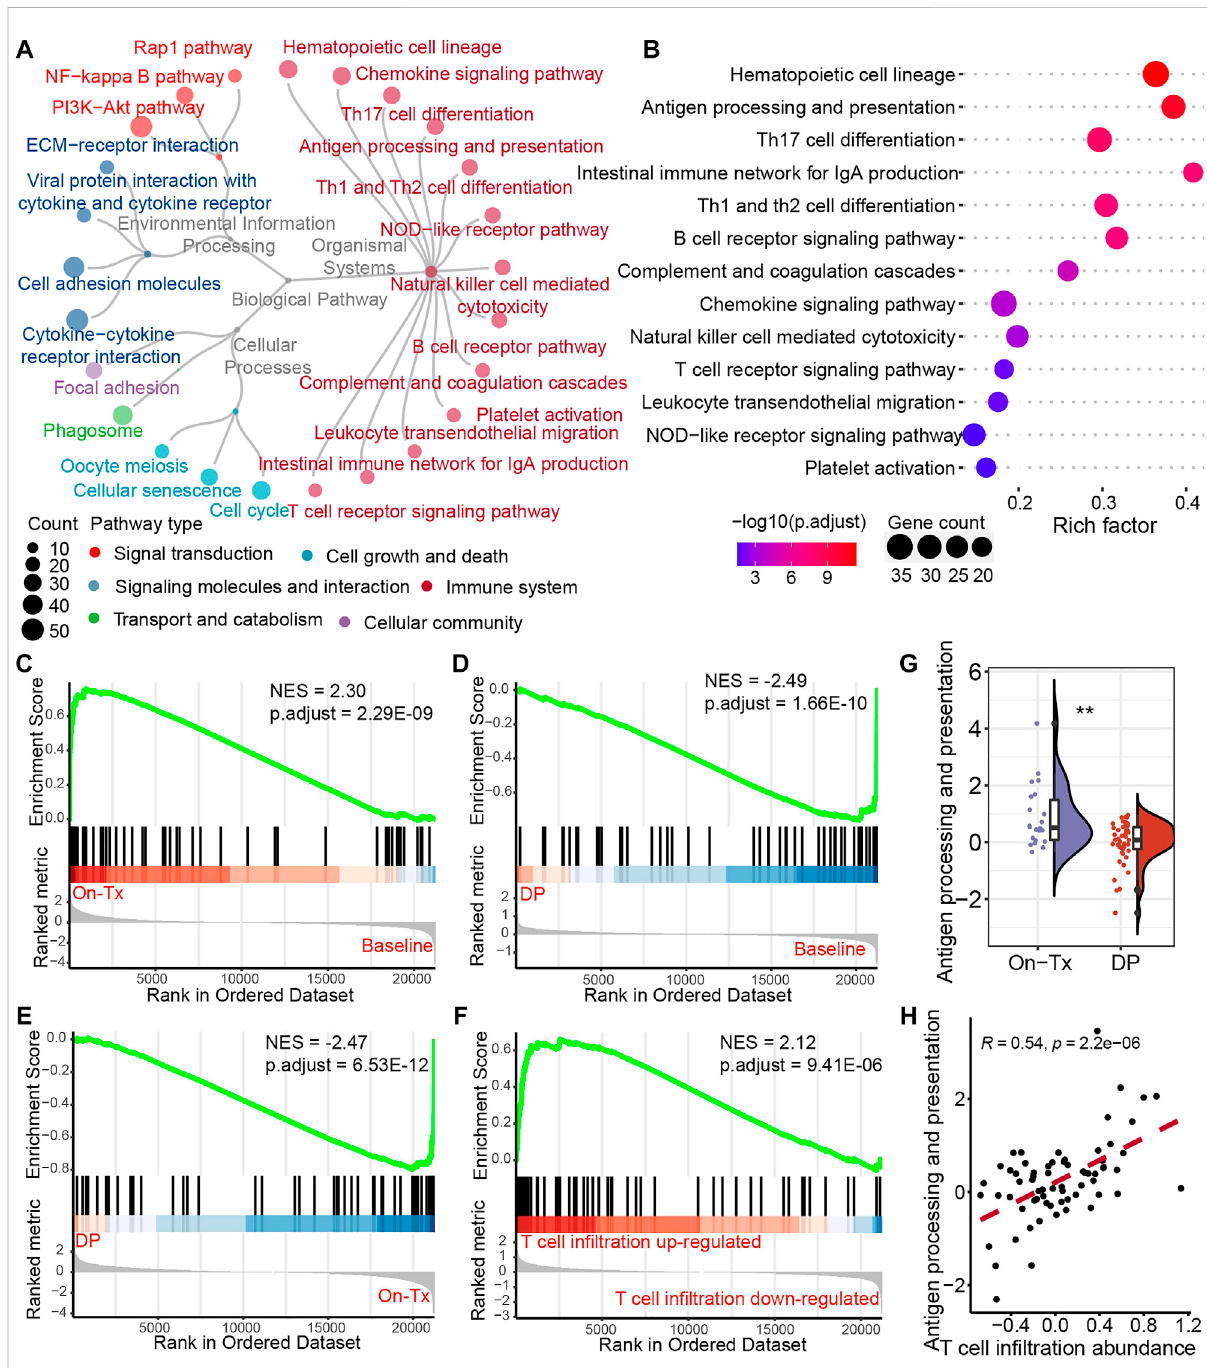
FIGURE 3 Potential regulatory pathways of T-cell in fi ltration during MAPK-targeted therapy. (A) The circular dendrogram shows the KEGG pathways that were signi fi cantly enriched (adjusted p -value < 0.05) for functional annotation using differentially expressed genes between On-Tx and DP biopsies (GSE75313, GSE65185, and EGAS00001000992). (B) The fi gure shows all the pathways belonging to the immune system in (A) . (C – E) Gene Set Enrichment Analysis (GSEA) showing antigen processing and presentation pathway activity at different stages of MAPK-targeted therapy, (C) between On-Tx and Baseline biopsies (D) between DP and Baseline biopsies, (E) between DP and On-Tx biopsies. (F) GSEA showing antigen processing and presentation pathway activity between resistance biopsies with up- and downregulated T cell in fi ltration abundance relative to baselinebiopsies. (G) Boxplotshowingdifferencesinlog2FCexpressionofantigenprocessingandpresentationpathwaybetweenon-treatmentand drug-resistancebiopsies.Thelog2FCwasobtainedbycomparisonwithpatient-matchedbaselinebiopsysamples.Statisticalanalysiswasperformed using the Wilcoxon test. (H) Scatter plot showing Pearson ’ s correlation between antigen processing and presentation pathway and abundance of Tcellin fi ltration. The valueusedto calculate thecorrelation waslog2FC expressionbetweenMAPKi-treatedand patient-matchedbaseline biopsies. pp p < 0.01. NES normalized enrichment